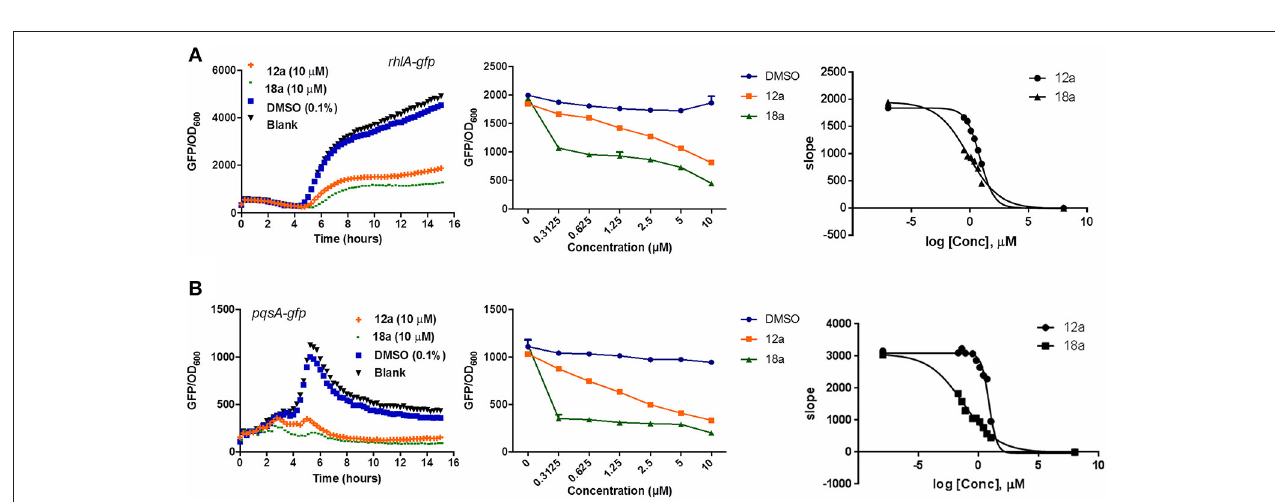
FIGURE 2 | QSI inhibition, dose-response and IC 50 values of compounds 12a and 18a on P. aeruginosa rhlA-gfp (A) and pqsA-gfp (B) . DMSO 0.1% was used as solvent control. For the IC 50 values, calculation was done using GraphPad Prism 6 software, taken at time point between 4 and 6h when QS inhibition started to occur. All experiments were done in triplicate manner (technical and biological replicates), only representative data are